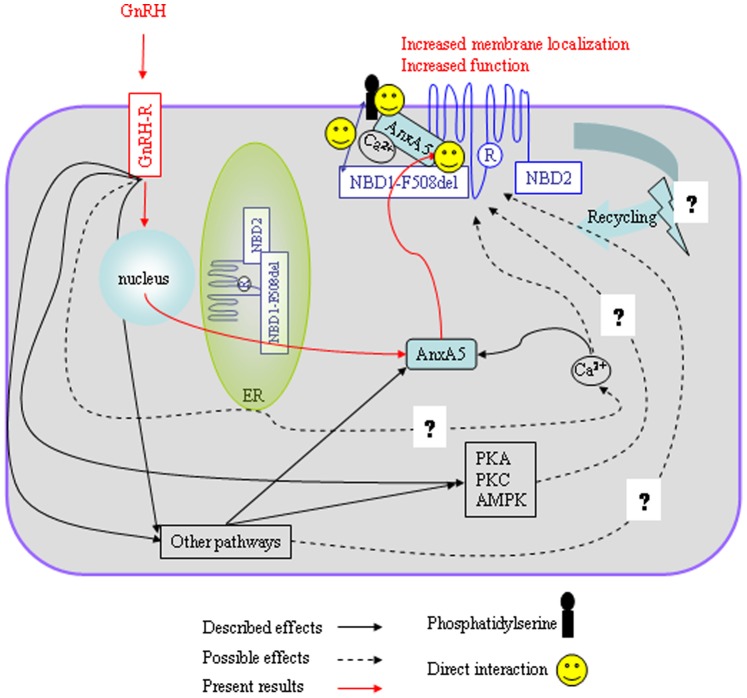
Schematic representation of the GnRH’s effect on F508del-CFTR function.We found that F508del-CFTR’s membrane localization and function are increased under GnRH treatment, associated with an increased expression of AnxA5 (red lines). Nevertheless, according to previous results, AnxA5 over expression is likely not the solely event triggered in cells by GnRH. Described events are summarized in black lines and their possible involvement upon F508del-CFTR activity are shown in dotted black lines.